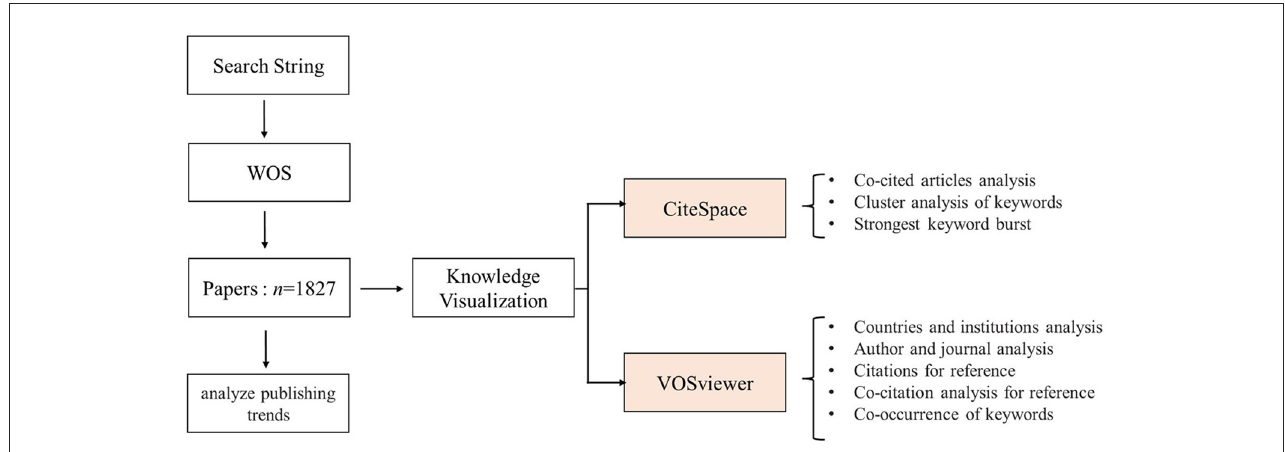
FIGURE1 The methodological flow diagram of the study. WOS, Web of